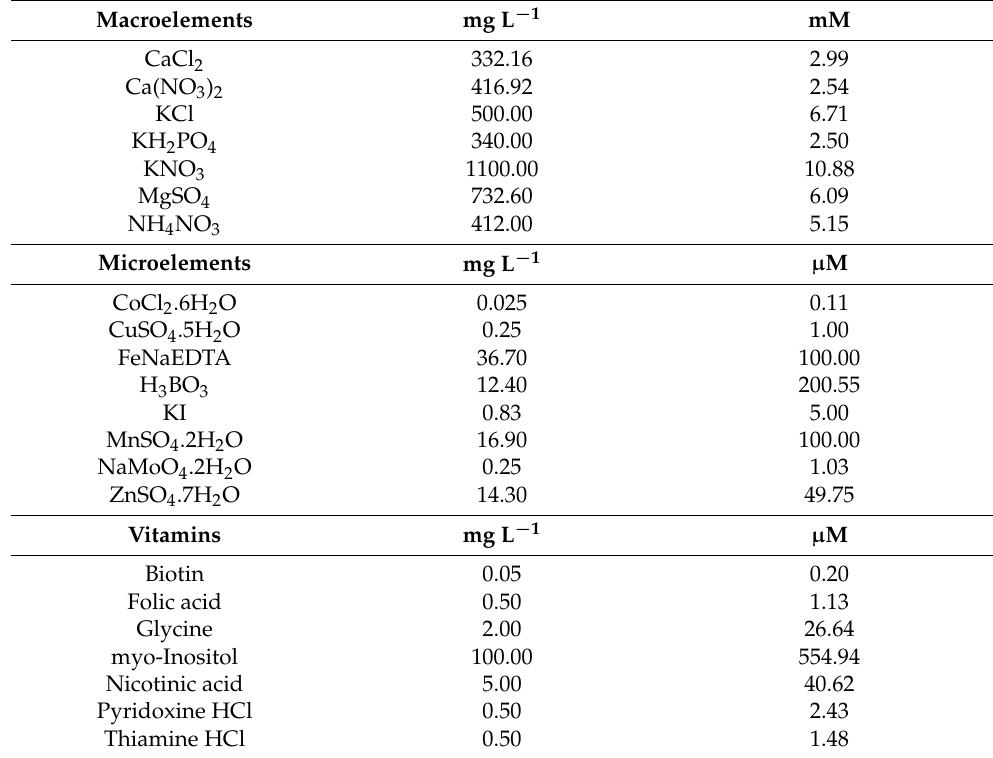
Table 3. Chemical composition of Ruggini Olive Medium (Duchefa).